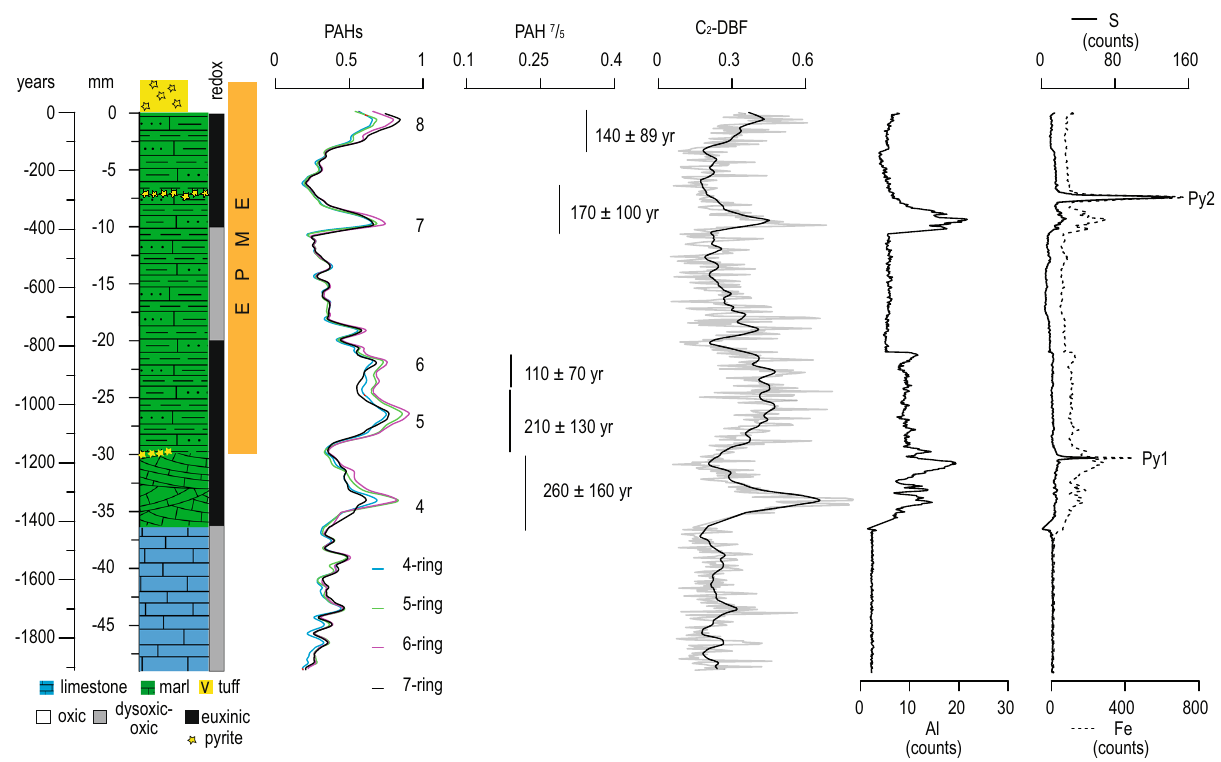
Fig. 4 | A high-resolution record from the top of Bed 24e. The four- to seven- ringed PAHs and mean values of PAH 7 / 5 for events 4 – 8 are shown as combustion markers and combustion temperature, respectively. C 2 -DBF and Al are shown as markers for soil and clastic input, respectively. S and Fe are shown to indicate the